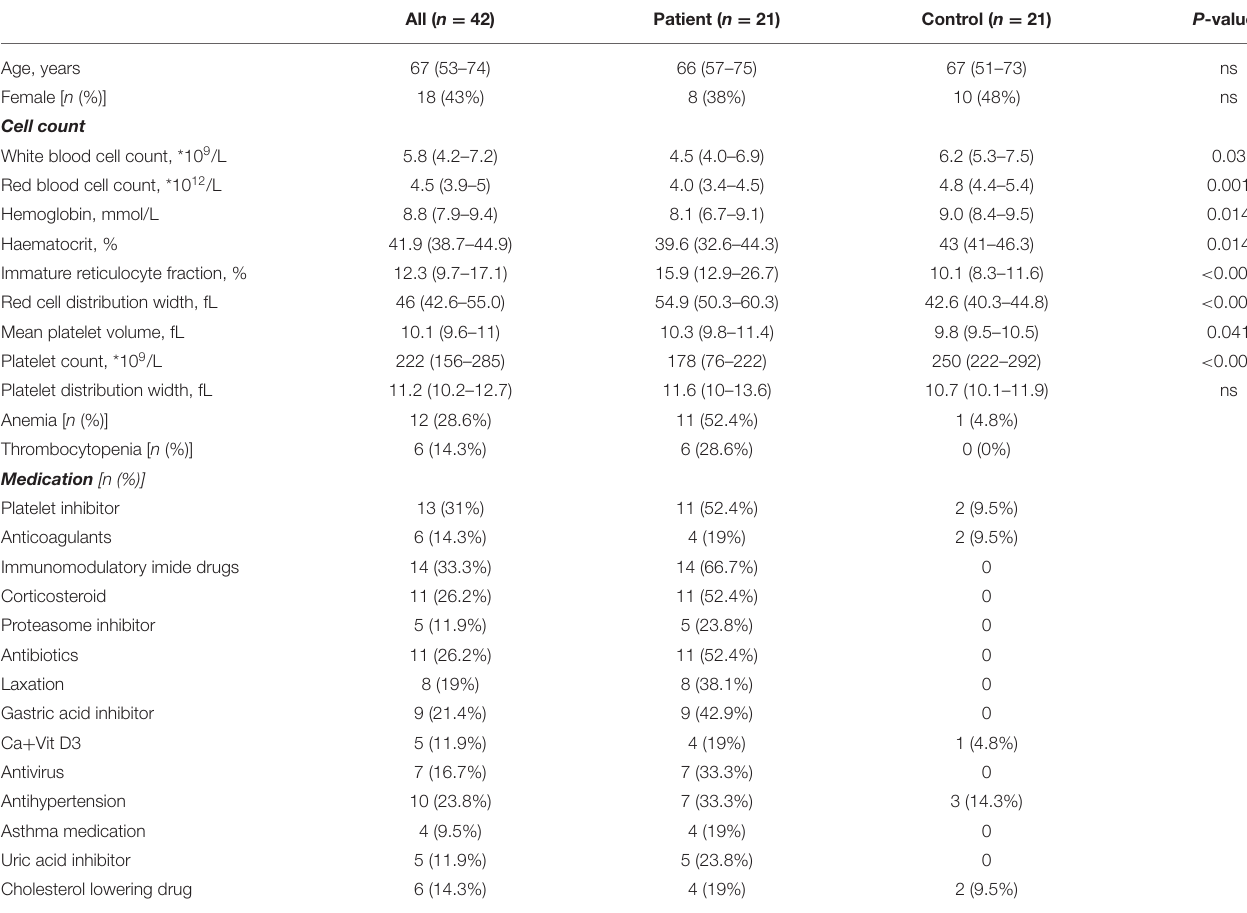
TABLE 1 | Baseline characteristics of patients and